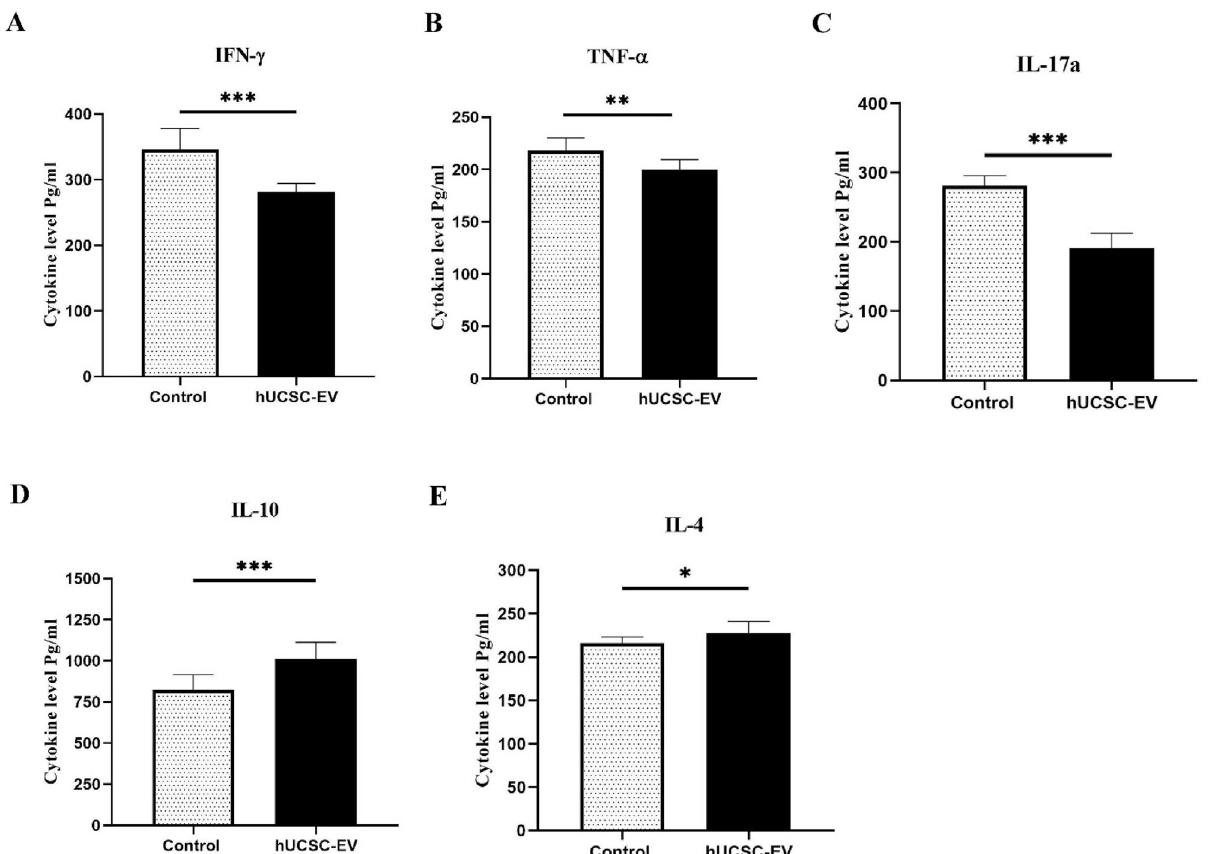
Figure 5. Analysis the secretion of pro-/anti-inflammatory cytokines by splenocytes in experimental groups. The mean levels of pro-inflammatory [IFN-γ ( A ), TNF-α ( B ), and IL-17a ( C )] and anti-inflammatory cytokines [IL-10 ( D ) and IL-4 ( E )]. Data are shown as mean ± SD. ***p < 0.001, **p < 0.01, and *p < 0.05. hUCSC-EV human umbilical cord mesenchymal stem cell-extracellular vesicle, IFN interferon, IL interleukin, SD standard deviation, TNF tumor necrosis factor.